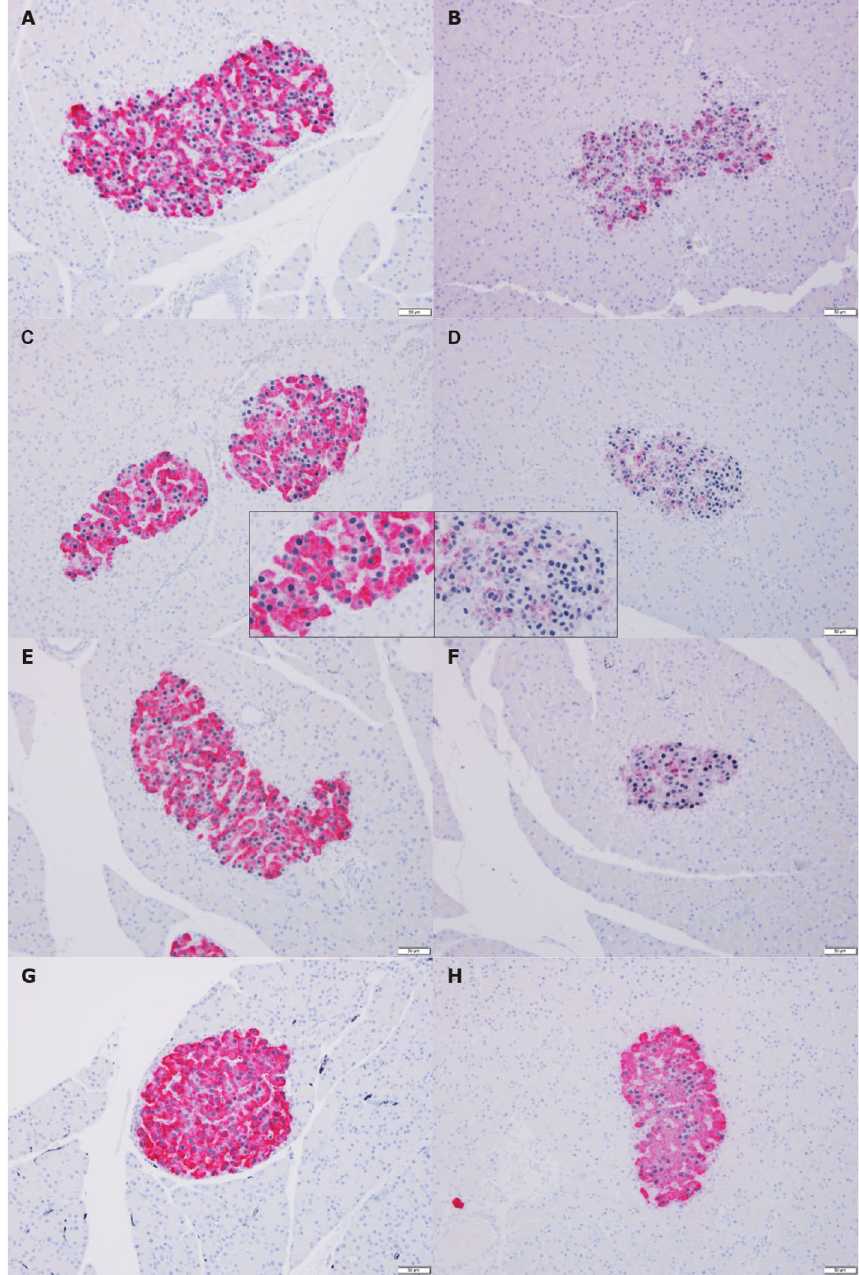
Figure 4. Microscopic images of pancreatic tissue double-stained for insulin (pink) and β-cell nuclei (black/ dark purple). Representative examples. Left panel: Controls, right panel: HI-infused animals. ( A ) + ( B ): Week 4, ( B ) is an example of islets with occasional positive staining for insulin, islets completely negative for insulin staining were as in Fig. 3B. ( C ) + ( D ): Week 8. Insert: magnified portion of the same islet to illustrate distribution of nuclei, ( E ) + ( F ): Day 2R, ( G ) + ( H ): Week 4R. R, recovery (infusion-free period). Magnification: × 200, scalebar: 50